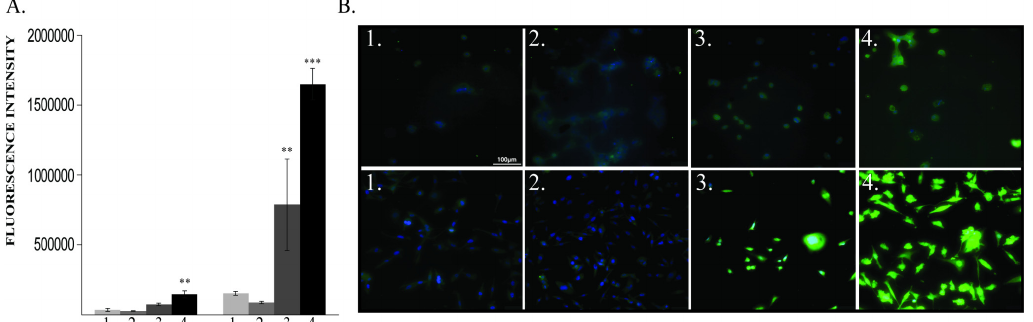
Figure 3. Brain-Derived Neurotrophic Factor (BDNF) protein expression. ( A ) BDNF protein quantification: left MCF10A, right MDA-MB-231; ( B ) Immunofluorescence pictures: upper panel MCF10A, lower panel MDA-MB-231; 1—21% O 2 , 2—40% O 2 , 3—60% O 2 , 4—80% O 2 . ** p < 0.005, ***